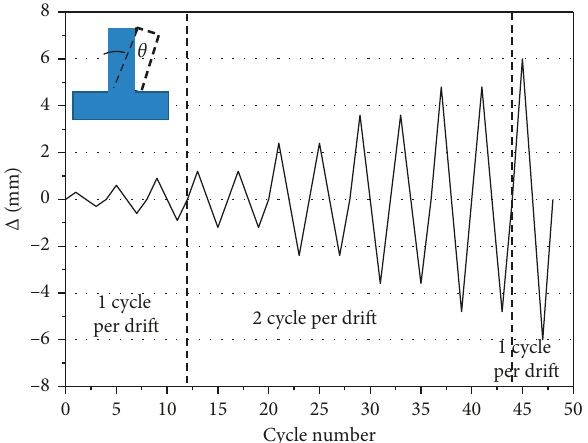
Figure 17: The loading